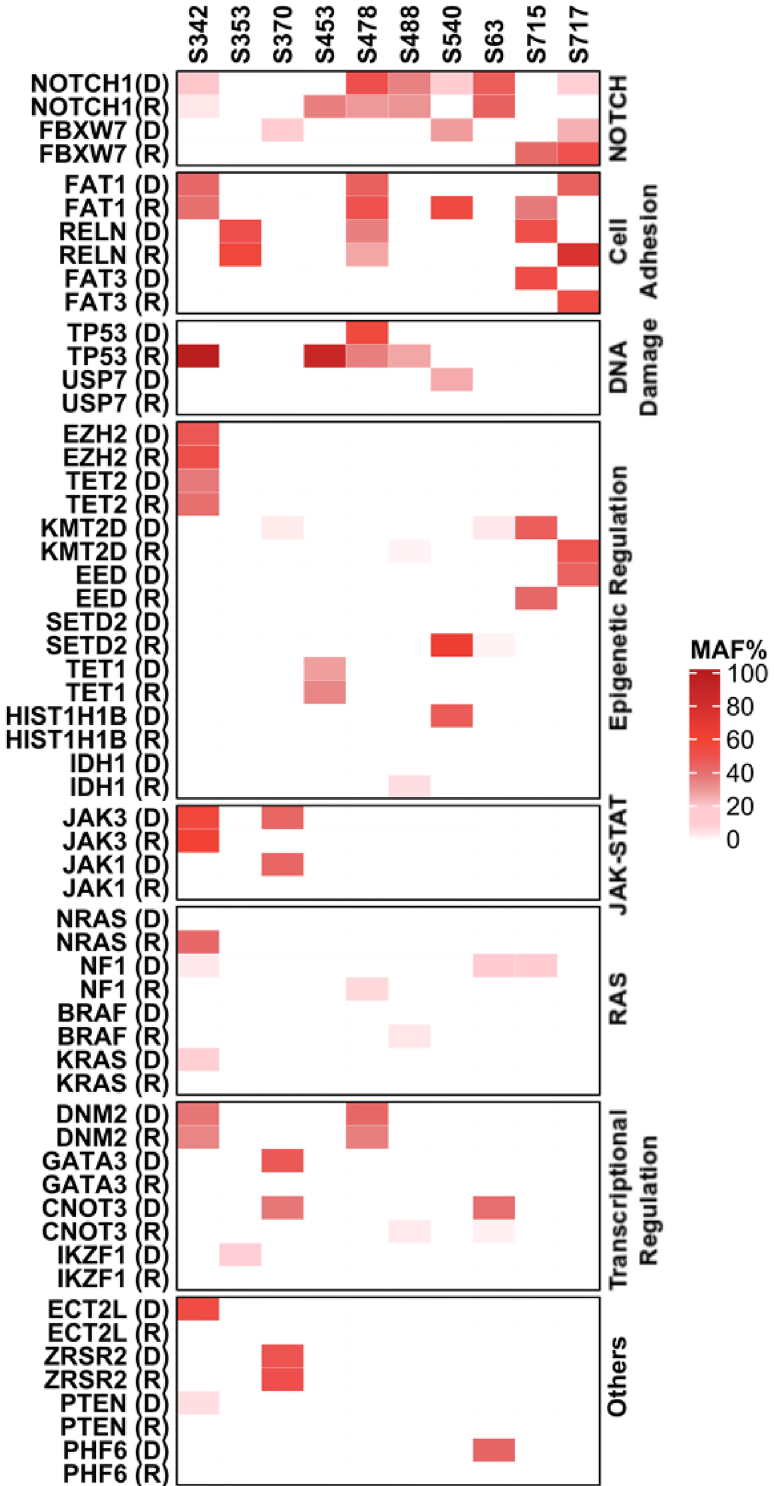
Figure 3. Mutation allele fractions in 29 genes differ between diagnosis and relapse in 10 patients. MAF mutation allele